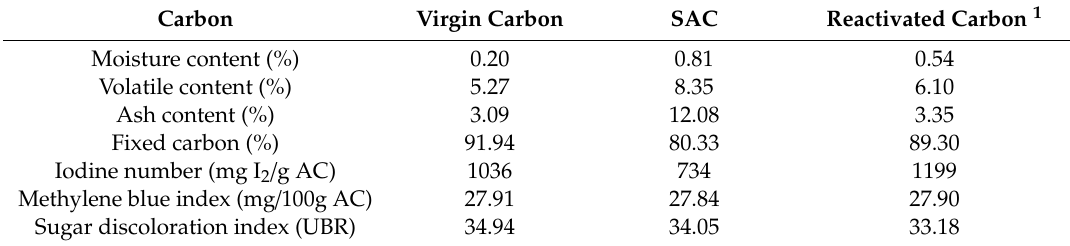
Table 5. Properties of virgin carbon, SAC, and reactivated carbon (moisture content (%),